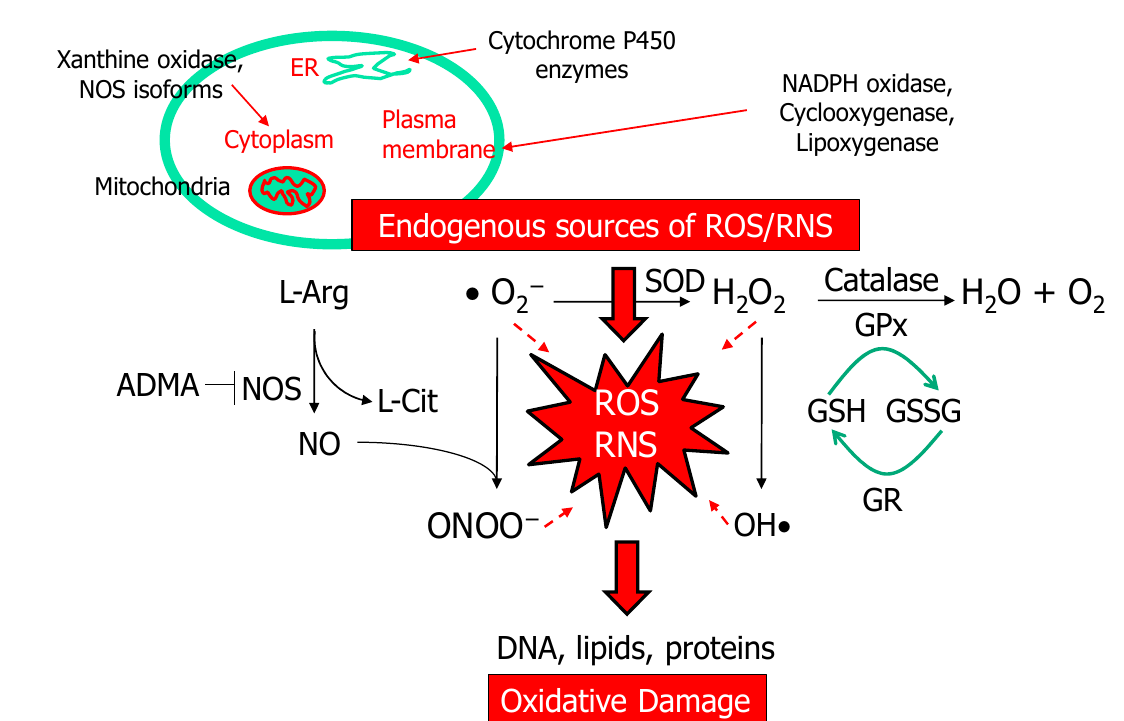
Figure 1. Schema outlining the reactive oxygen species (ROS)- and reactive nitrogen species (RNS)-generating pathways and antioxidant defense systems. Both the ROS and RNS are derived from endogenous sources like mitochondria, endoplasmic reticulum (ER), cytoplasm, and plasma membrane etc. Many enzymes produce superoxide radical (O 2 − ) intracellularly, including NADPH oxidase, mitochondrial respiration chain, xanthine oxidase, cytochrome P450 enzymes, cyclooxygenase, and lipoxygenase. Nitric oxide synthase (NOS) catalyzes L -arginine ( L -Arg) to generate nitric oxide (NO) and L -citrulline ( L -Cit). However, uncoupled NOS produces superoxide, which scavenges NO leading to the peroxynitrite (ONOO − ) formation. On the contrary, excessive ROS can be offset by the action of antioxidant enzymes. The components of antioxidant defense are superoxide dismutase (SOD), glutathione peroxidase (GPx), catalase, and glutathione reductase (GR). Reduced glutathione (GSH), a radical scavenger, is converted into oxidized glutathione (GSSG) through GPx and converted back to GSH by GR. Oxidative stress is a condition where ROS overwhelms the antioxidant system, which leads to cellular injury in the form of damaged DNA, lipids and proteins. RNS are produced starting with the reaction of superoxide and NO to form peroxynitrite.